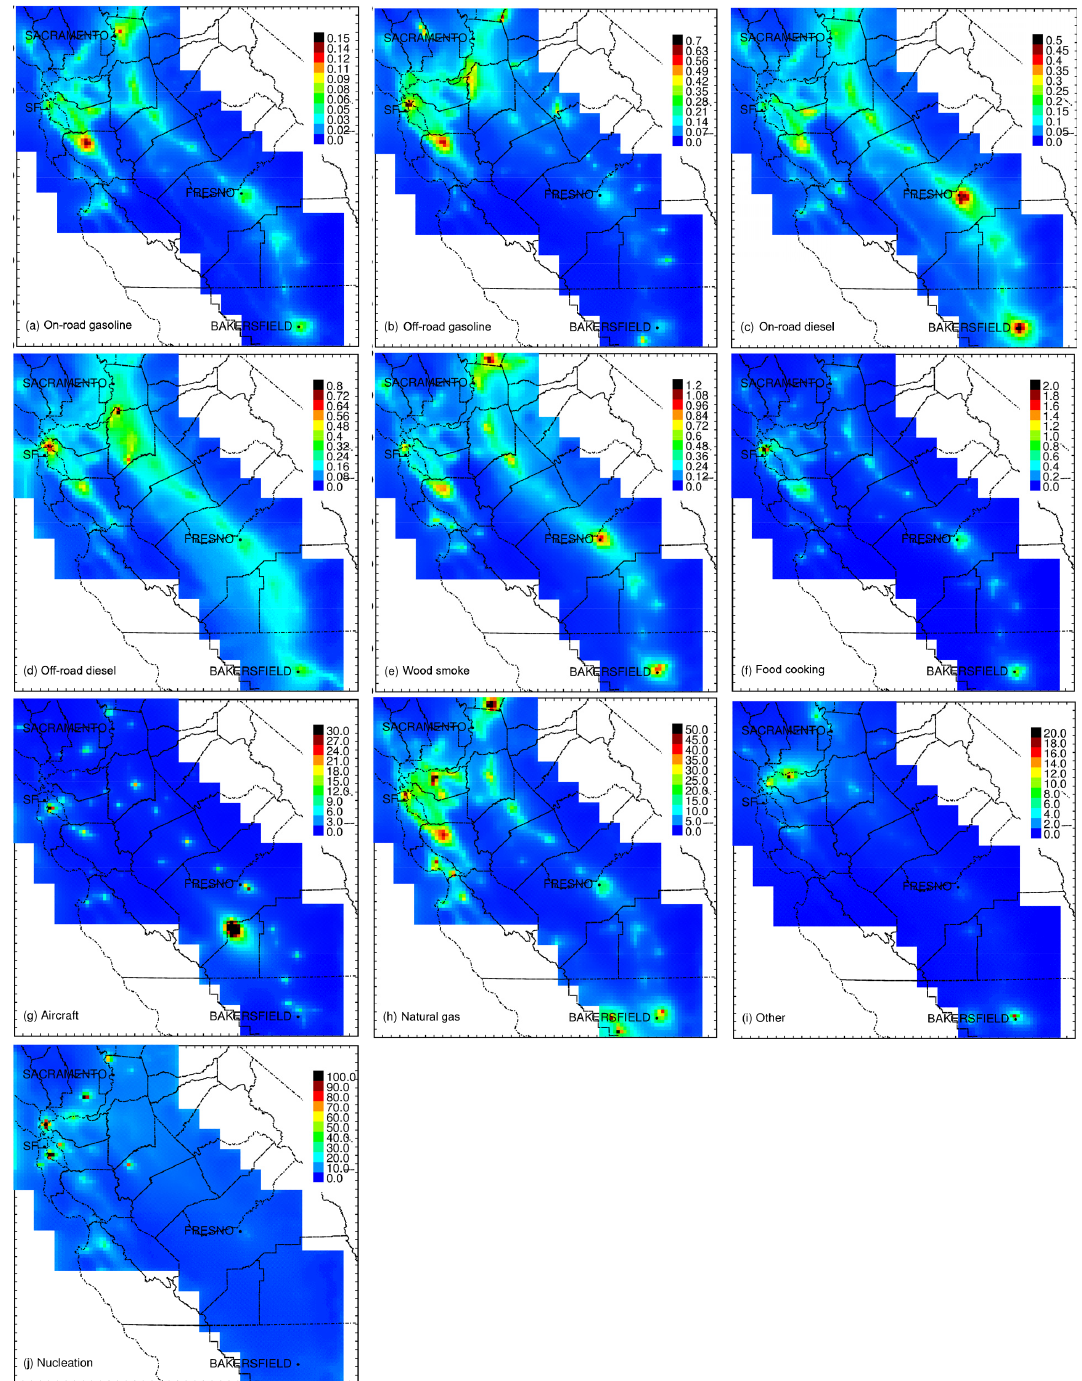
Figure 19. Spatial distribution of particle number from major sources in northern California. Units are kcountscm − 3